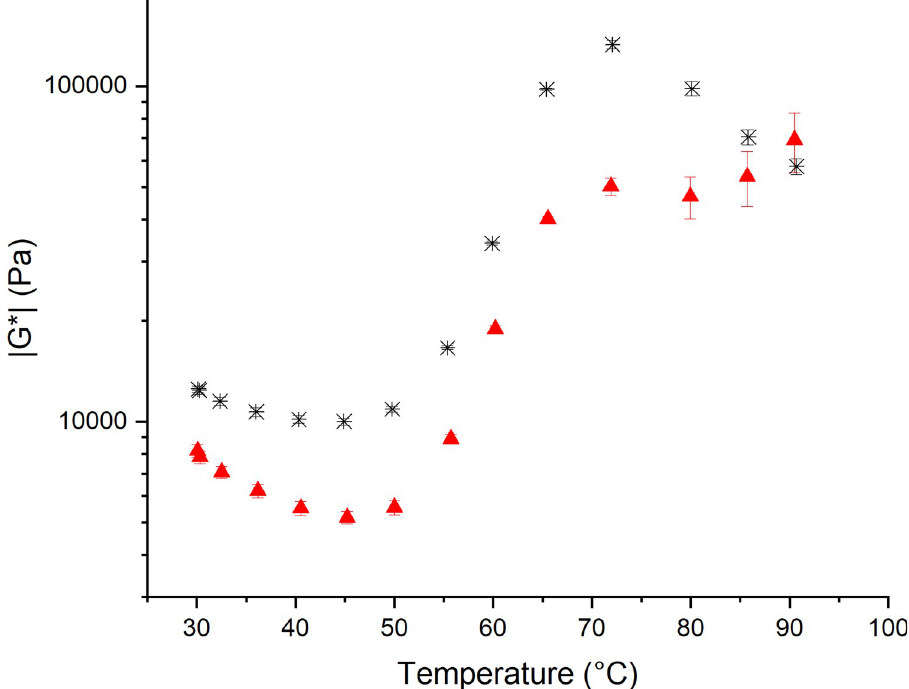
Fig 1. Complex modulus retrieved from shear rheological measurements at γ = 0.03% at 1 Hz after 60 min resting/fermenting at 30˚C and subsequent heating. ( � ) Standard non-yeasted wheat dough and ( ▲ ) yeasted